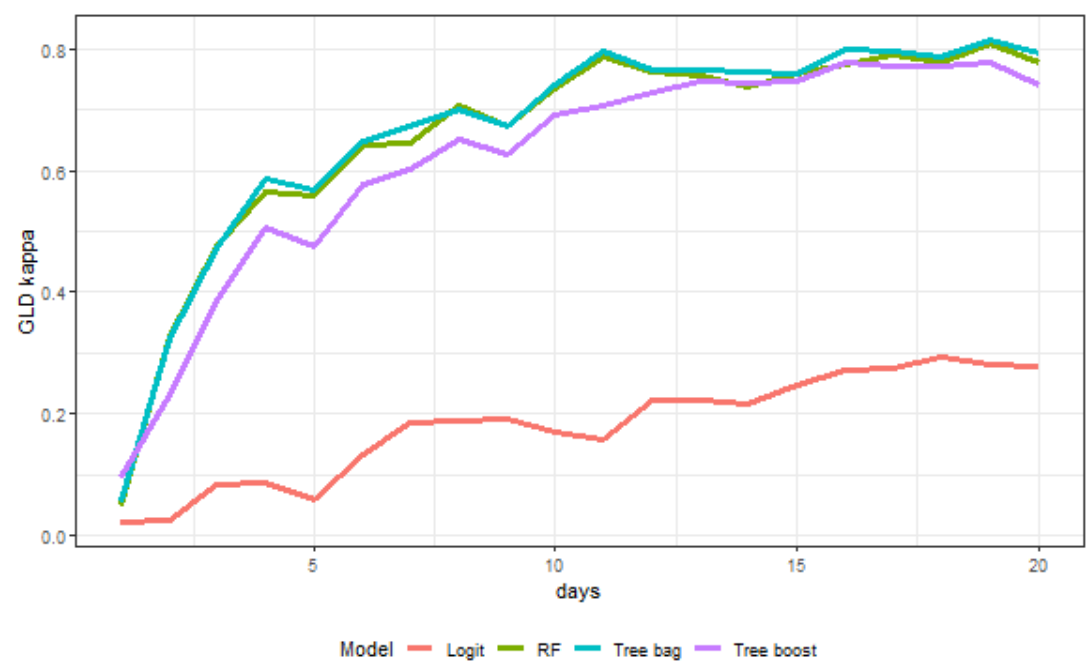
Figure 6. This figure shows the multi-period kappa accuracy for GLD price direction.